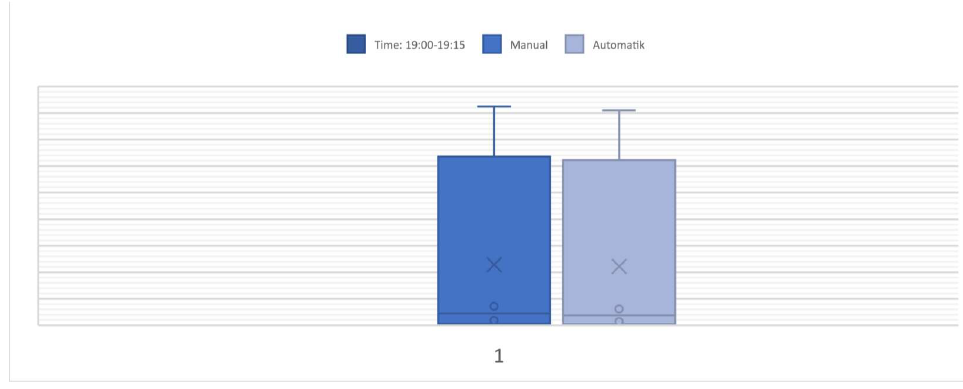
Figure 9. Difference between automatic and manual vehicle counts (time 19:00–19:15).